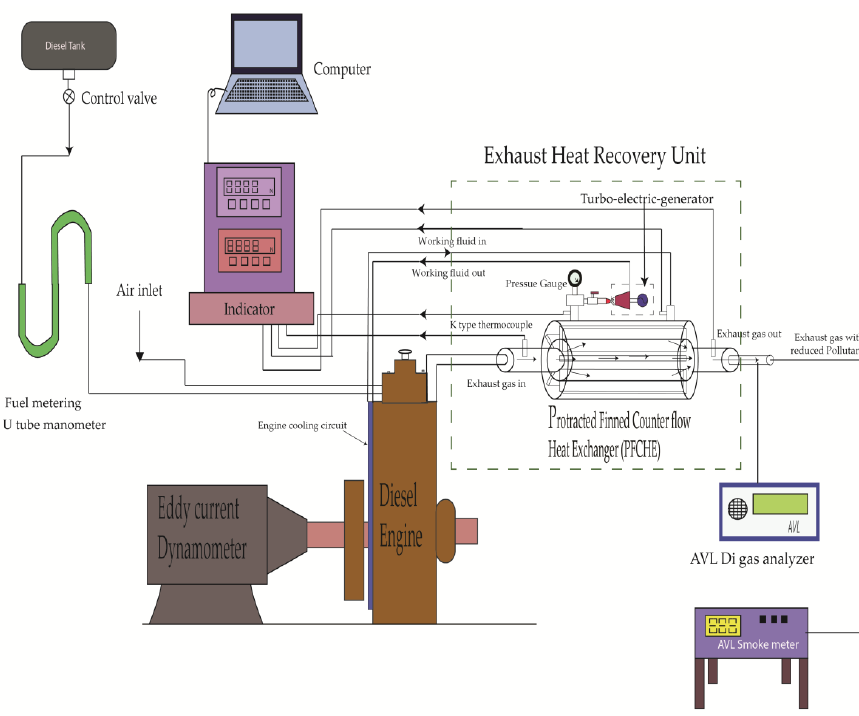
Figure 1. Schematic diagram of experimental setup.